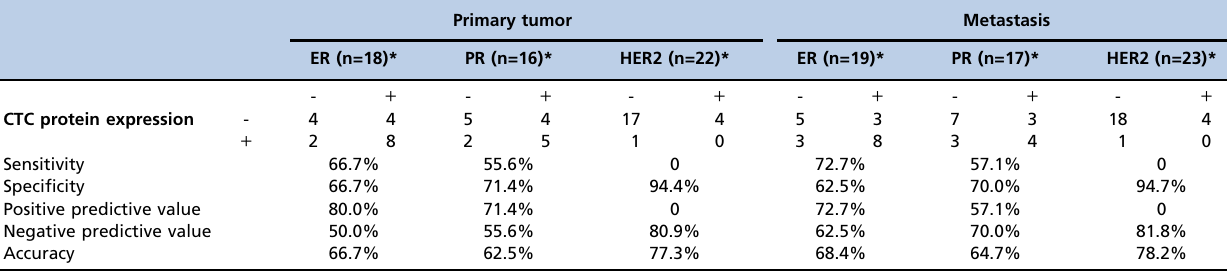
Table 4 - Comparison of protein expression between CTCs, primary tumors, and